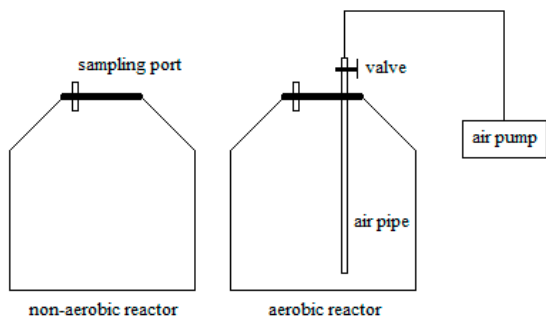
Figure 2. Schematic of reactors assembled with sampling ports and valves for storage of wood chips.